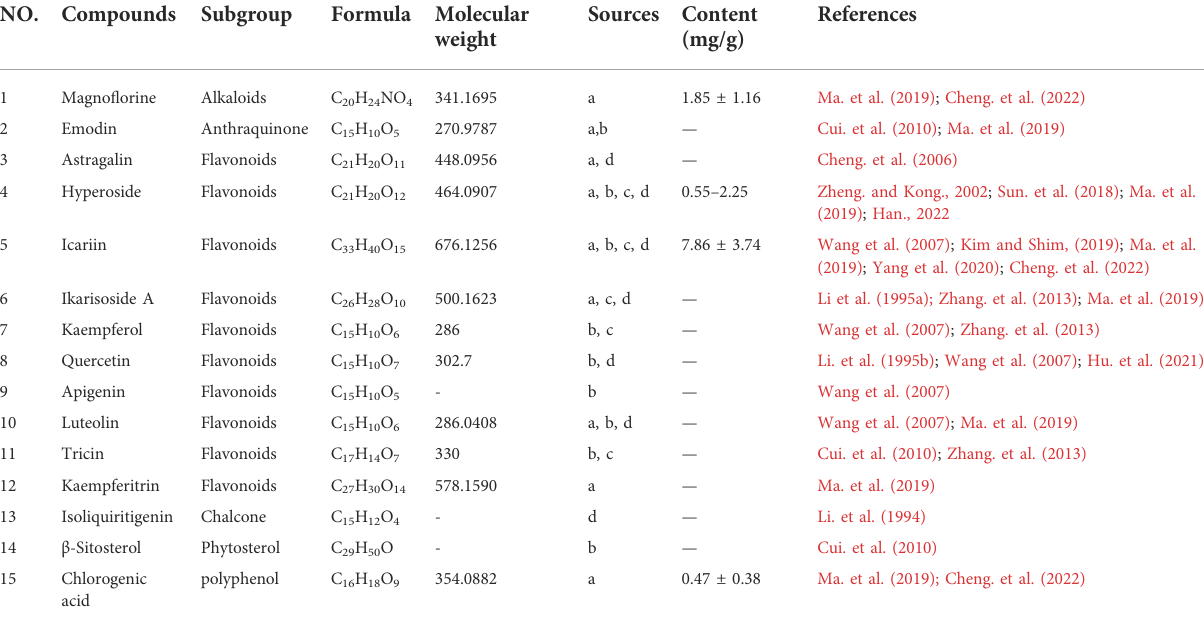
TABLE 2 Compounds from EH for the treatment of RA.